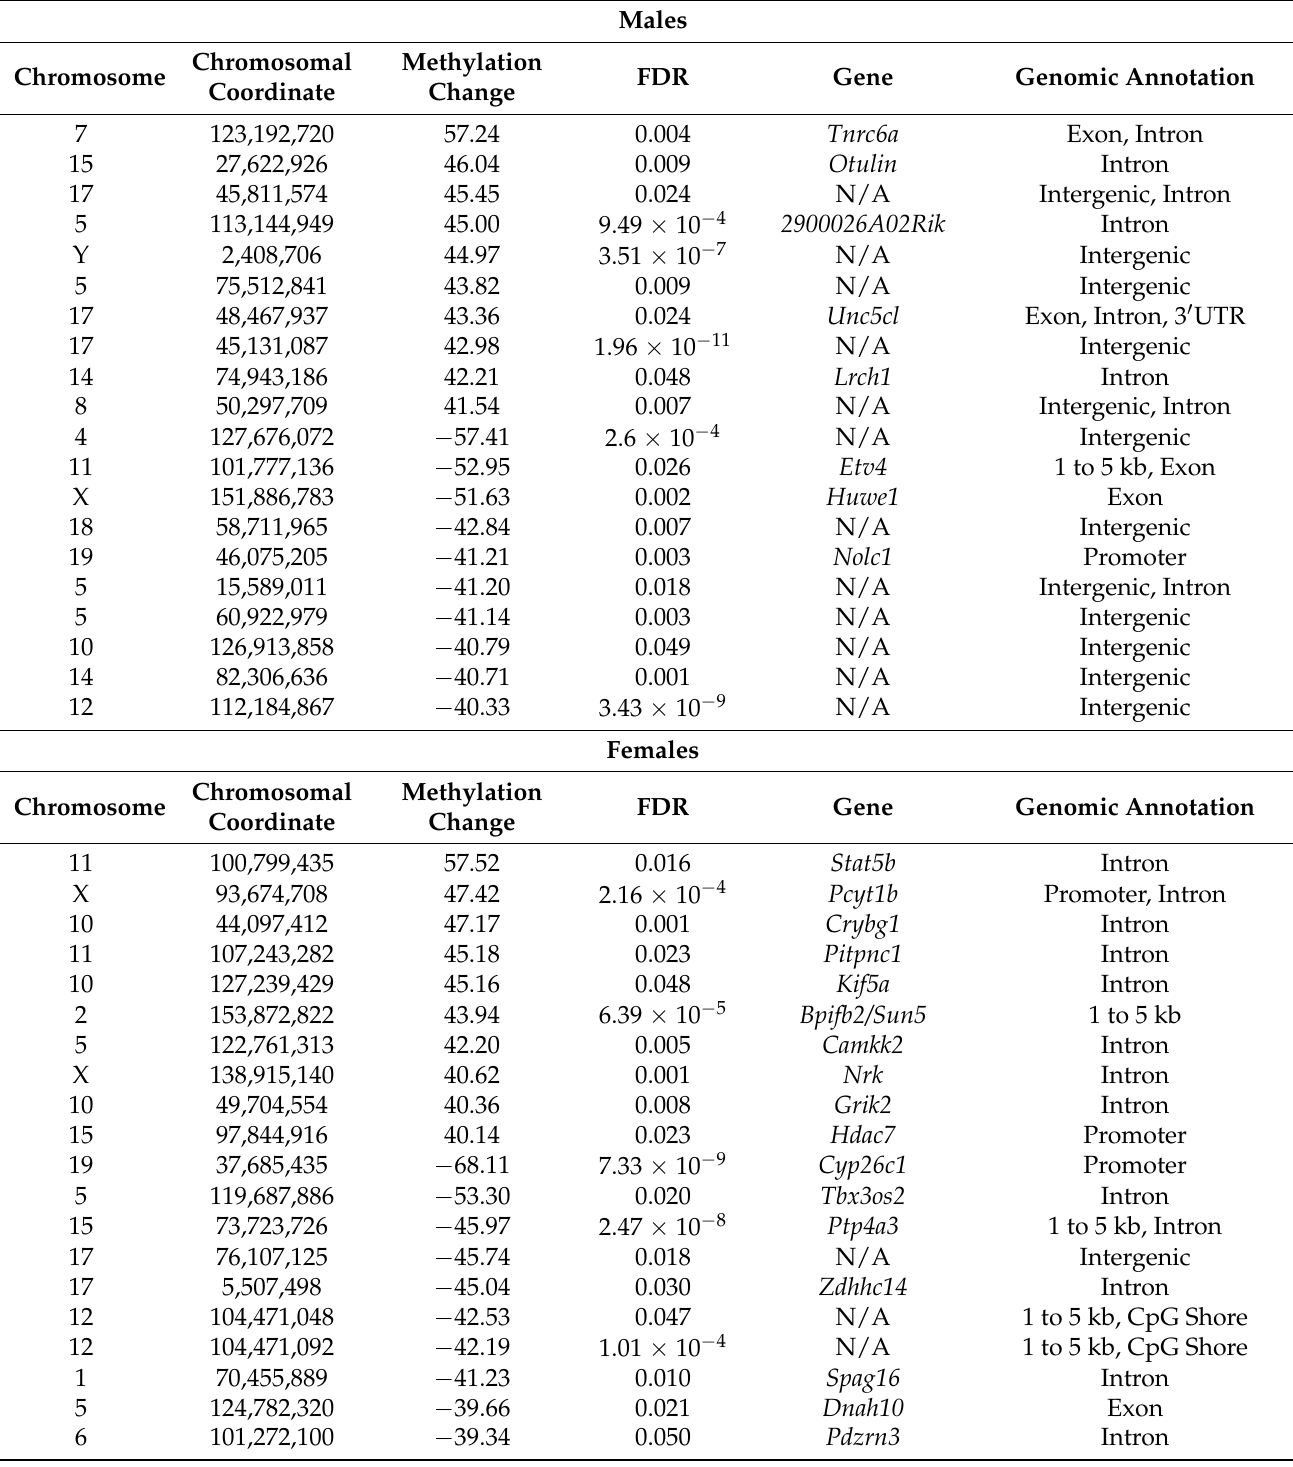
Table 3. Top 10 differentially hypo- and hyper-methylated cytosines (DMCs) in each sex, ranked by methylation change.